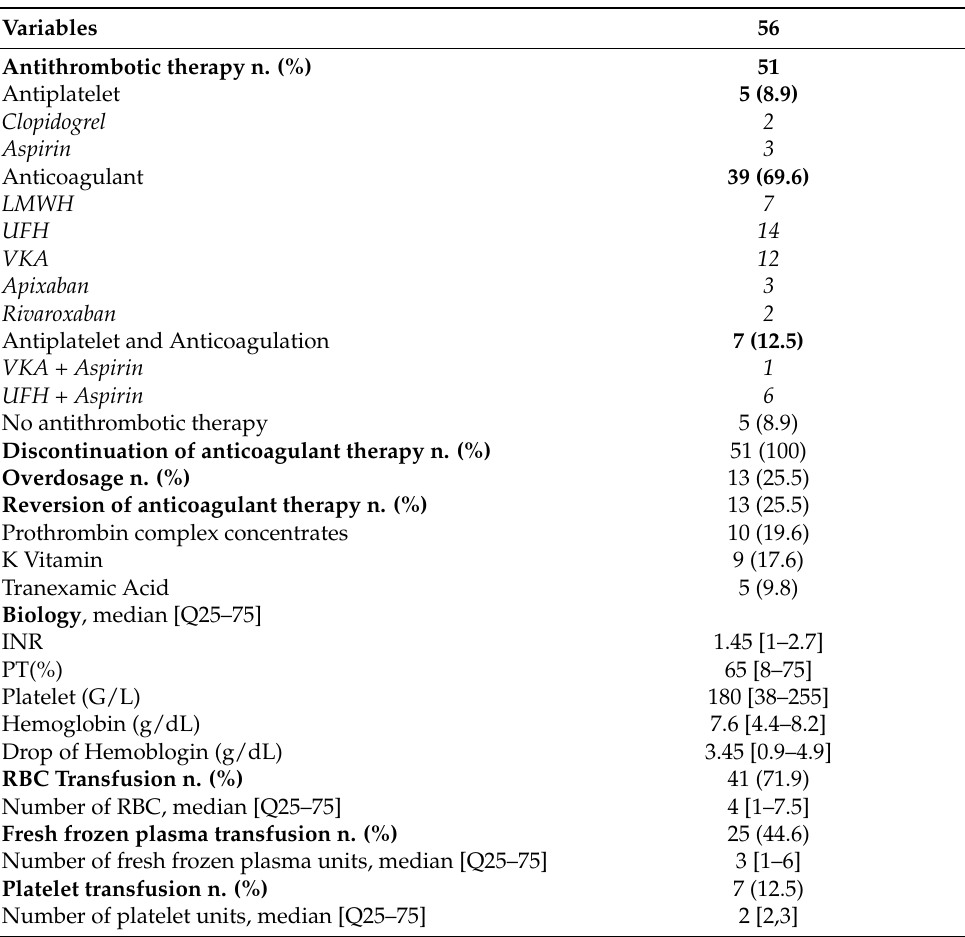
Table 2. Patient biological